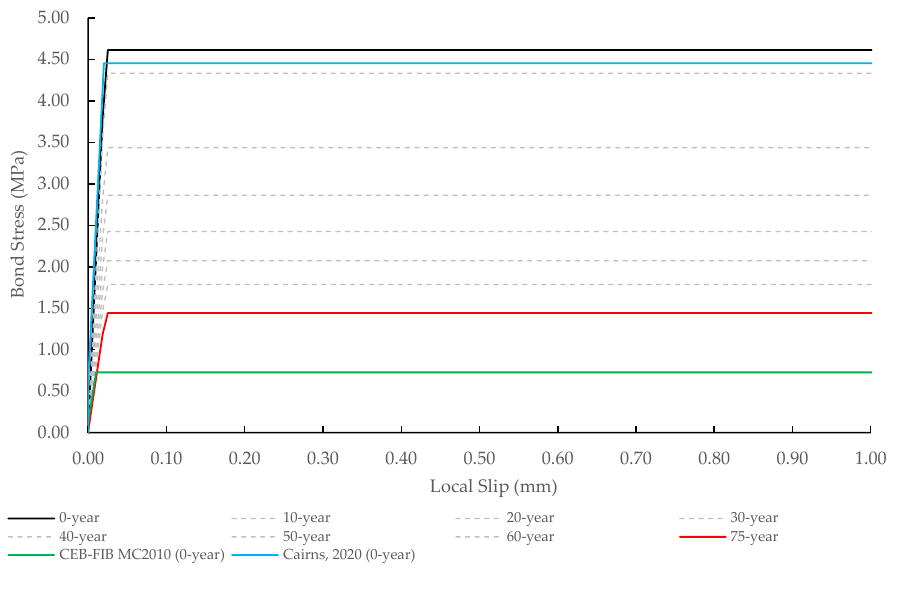
Figure 13. Local bond–slip relationship.